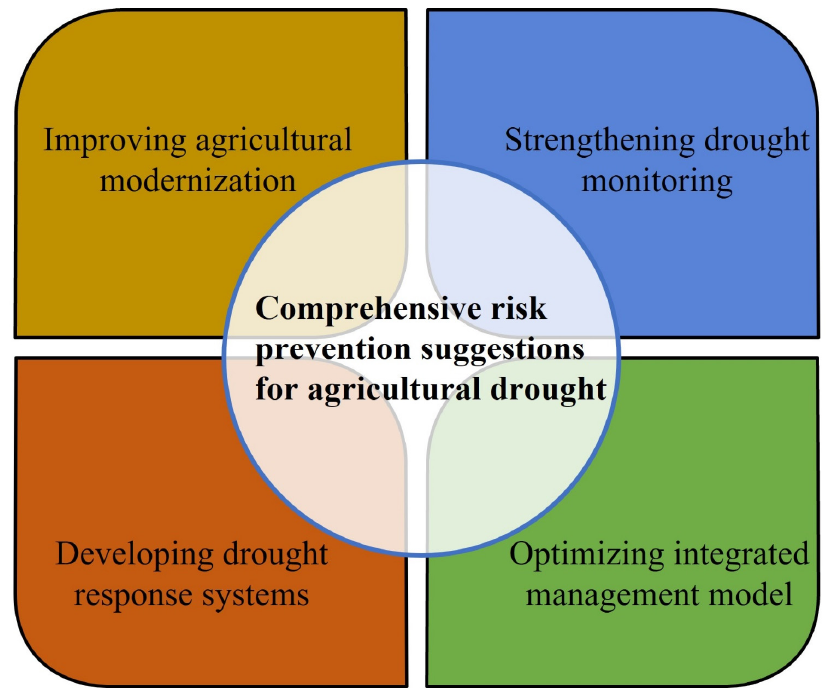
Figure 14. Integrated risk prevention model for agricultural drought.